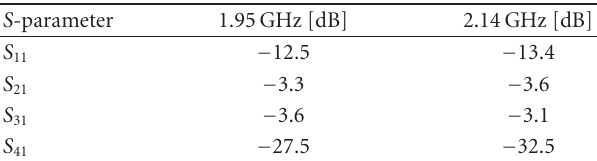
Figure 3: Simulated S -parameter results for the MS/NRI coupled- line coupler of Figure 2. Table 2: Simulated S -parameters for the MS/NRI coupled-line coupler.